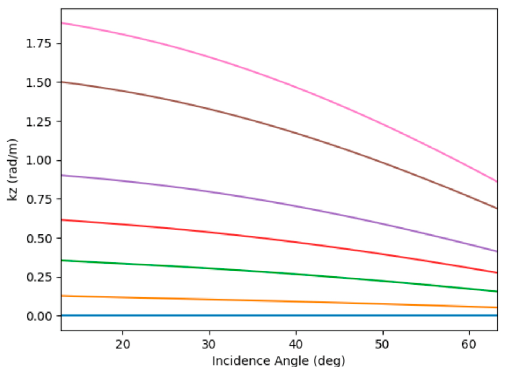
Figure 3. Vertical wavenumber as a function of incidence angle for the different baselines within the acquisition geometry.